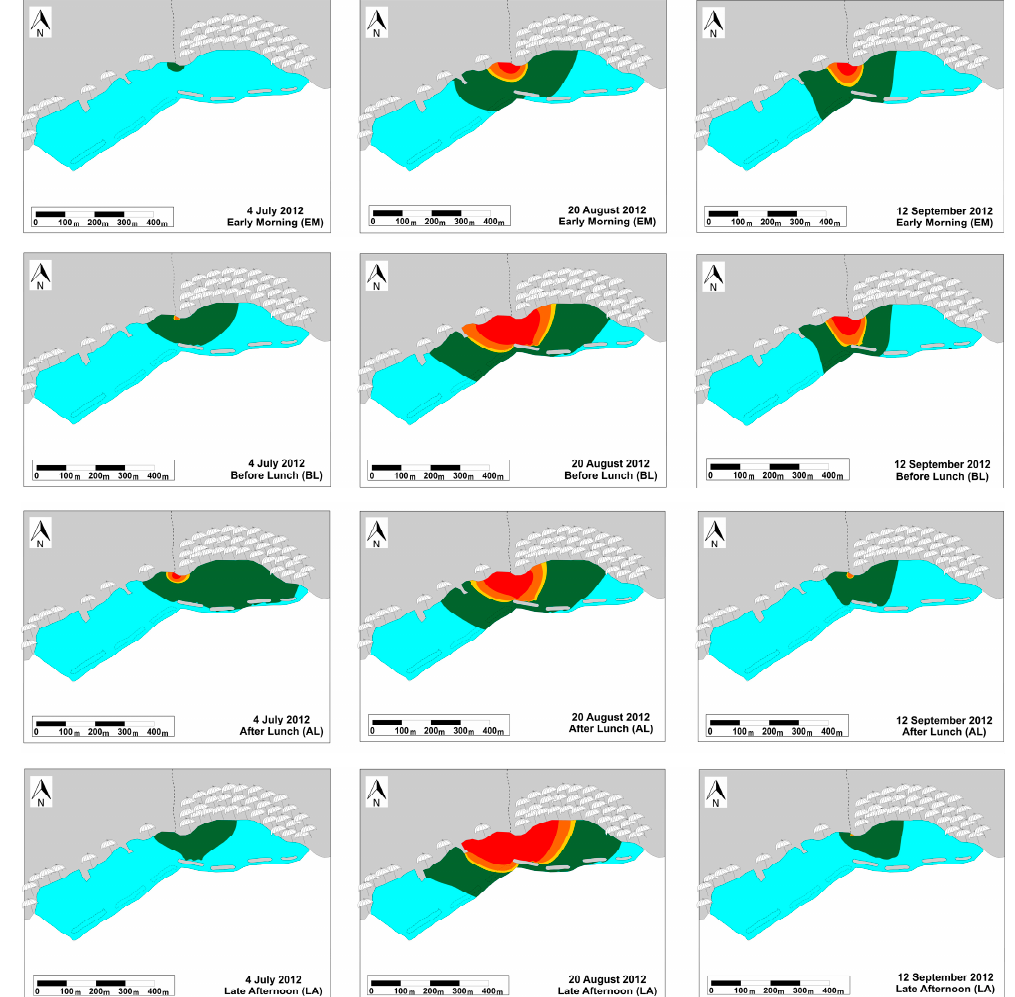
Figure 4. Concentration of VBNC E. coli within the classified survey area according to the water quality criterion reported in the Legislative Decree 116/2008 (red = water banned for bathing use; orange = poor quality; yellow = sufficient quality; green = good quality; light blue = excellent quality). The microbiological water quality within La Perla del Tirreno bathing area was calculated in the three sampling days of summer 2012 (July, August, September, in columns) and the four considered daily periods (in rows).